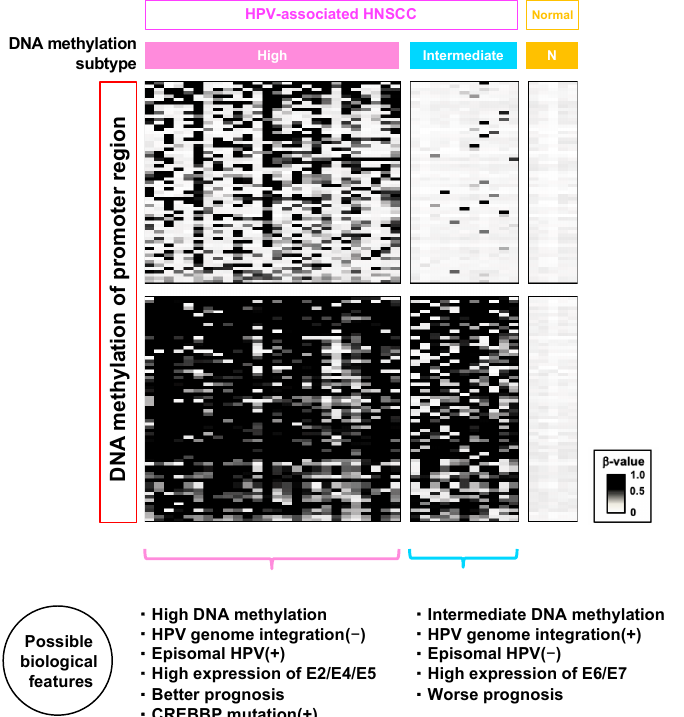
Figure 3. Distribution of DNA methylation pattern and biological characteristics in HPV-associated OPSCC. Genome-wide DNA methylation analysis revealed two types of DNA methylation patterns in HPV-associated OPSCC. In high DNA methylation subtype, HPV genome integration ( − ), episomal HPV (+), high expression of E2/E4/E5, and better prognosis compared to the intermediate DNA methylation subtype and CREBBP mutation (+) were previously reported. In intermediate DNA methylation subtype, HPV genome integration (+), episomal HPV ( − ), high expression of E6/E7, and worse prognosis compared to the high DNA methylation subtype were reported.